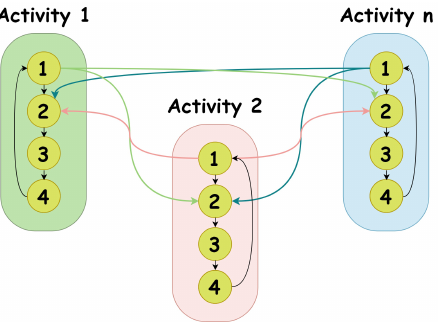
Figure 2. Hidden state transition graph. The activities represent X , and the numbers 1–4 represent U and stand for the four gait phases, or leg